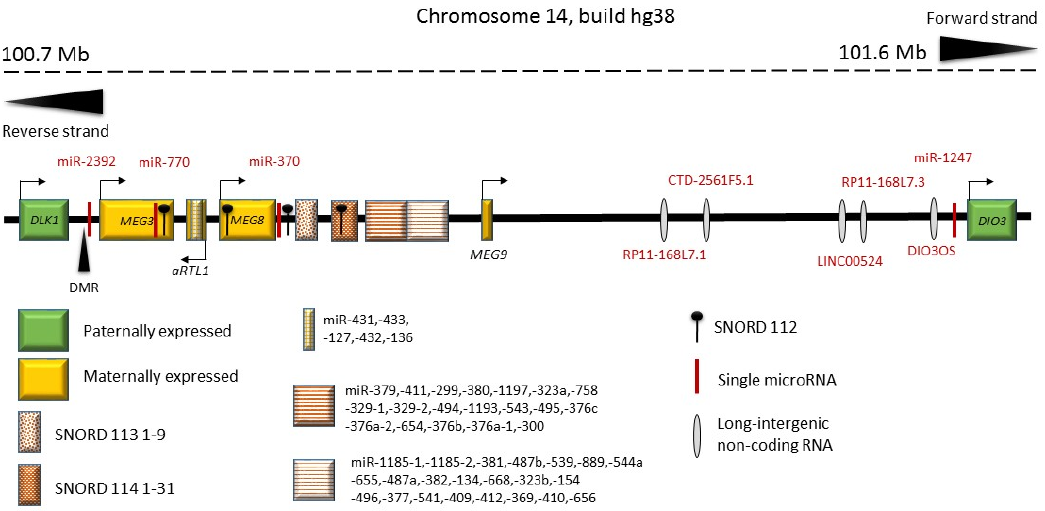
Figure 4. An overview of the imprinted genomic region on human chromosome 14 between DLK1 and DIO3 . Genes marked in green are paternally expressed and genes marked in orange are maternally expressed. DMR: the MEG3 differentially methylated region. Shown are also single miRNAs, the miRNA clusters, SNORD genes and other ncRNAs. Redrawn and updated with inspiration from Benetatos et al. (2013) [157] .